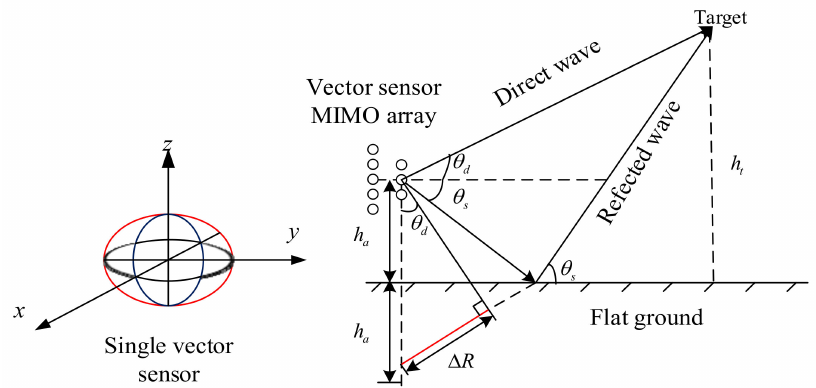
Figure 1. Signal model of meter wave polarimetric MIMO radar in a low-elevation